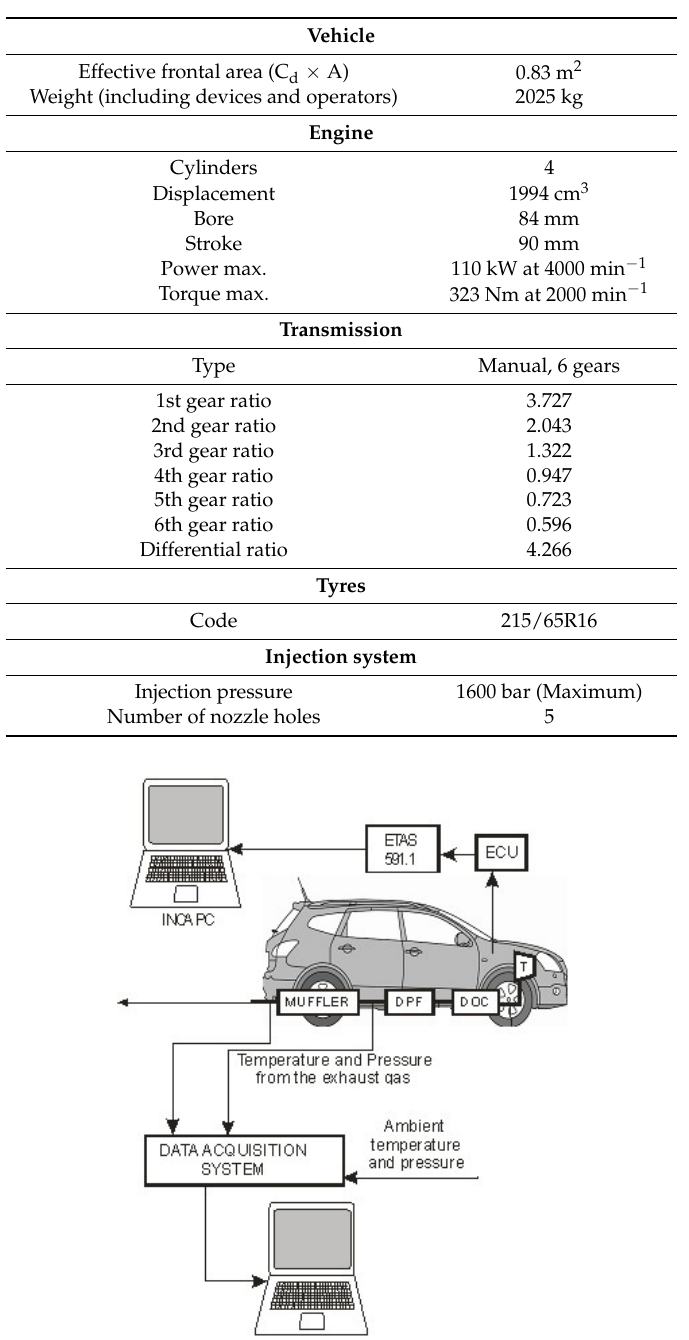
Table 1. Main vehicle and engine characteristics.